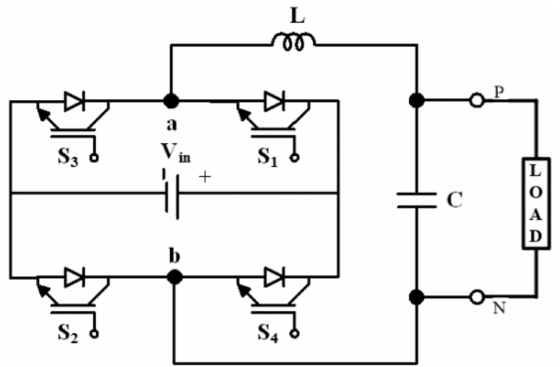
Figure 2. Circuit of proposed